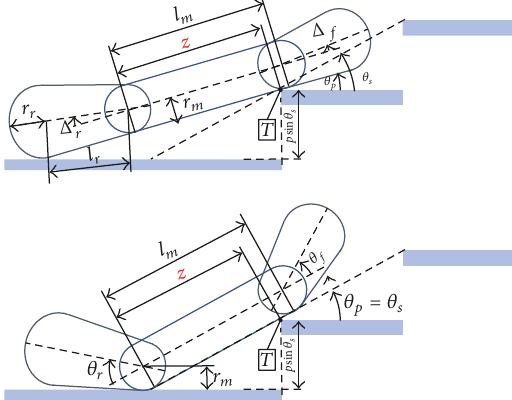
Figure 15: State before and after switching the control method.